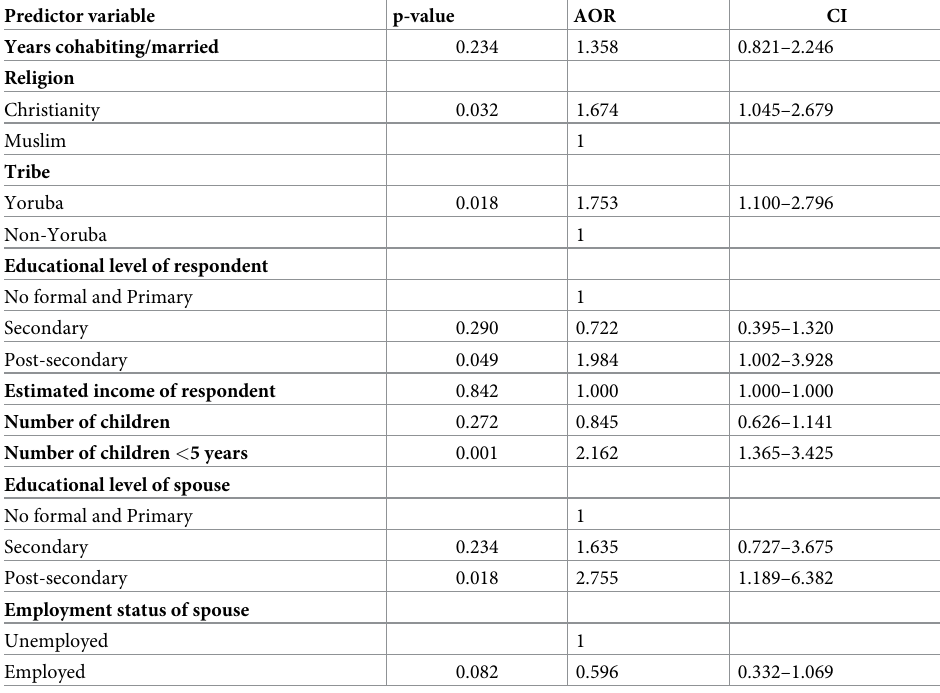
Table 9. Predictors of good knowledge of maternal, newborn and child health.